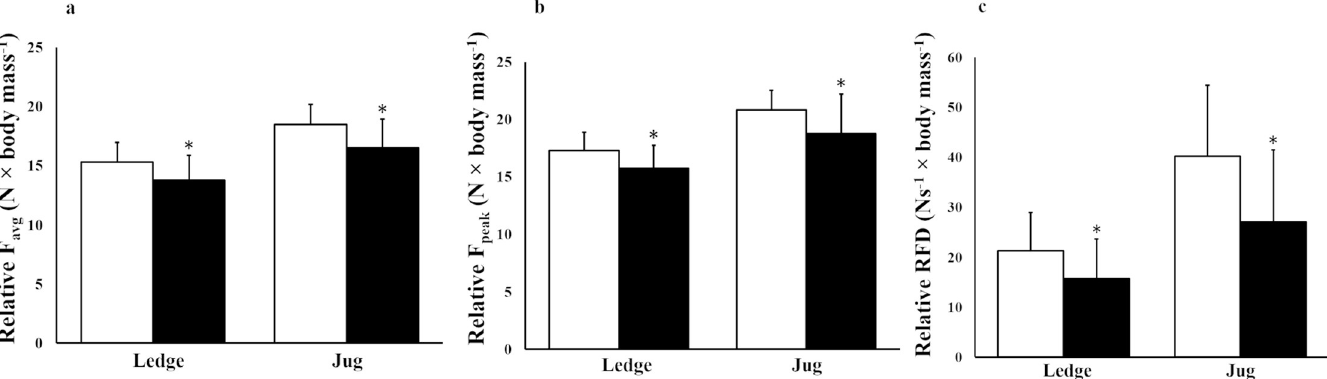
Fig 5. Results relative to body mass from average force (F avg ) (a), peak force (F peak ) (b) and rate of force development (RFD avg ) (c) between the groups for the isometric ledge and jug conditions. White bars represent boulder climbers and black bars represent lead climbers. Error bars represent standard deviations. ( � p < 0.05; �� p <